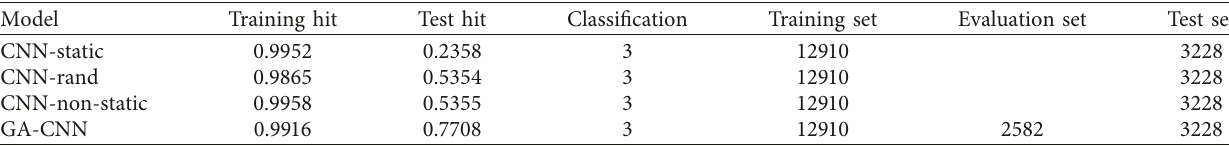
Table 2: Comparison of GA-CNN and CNN